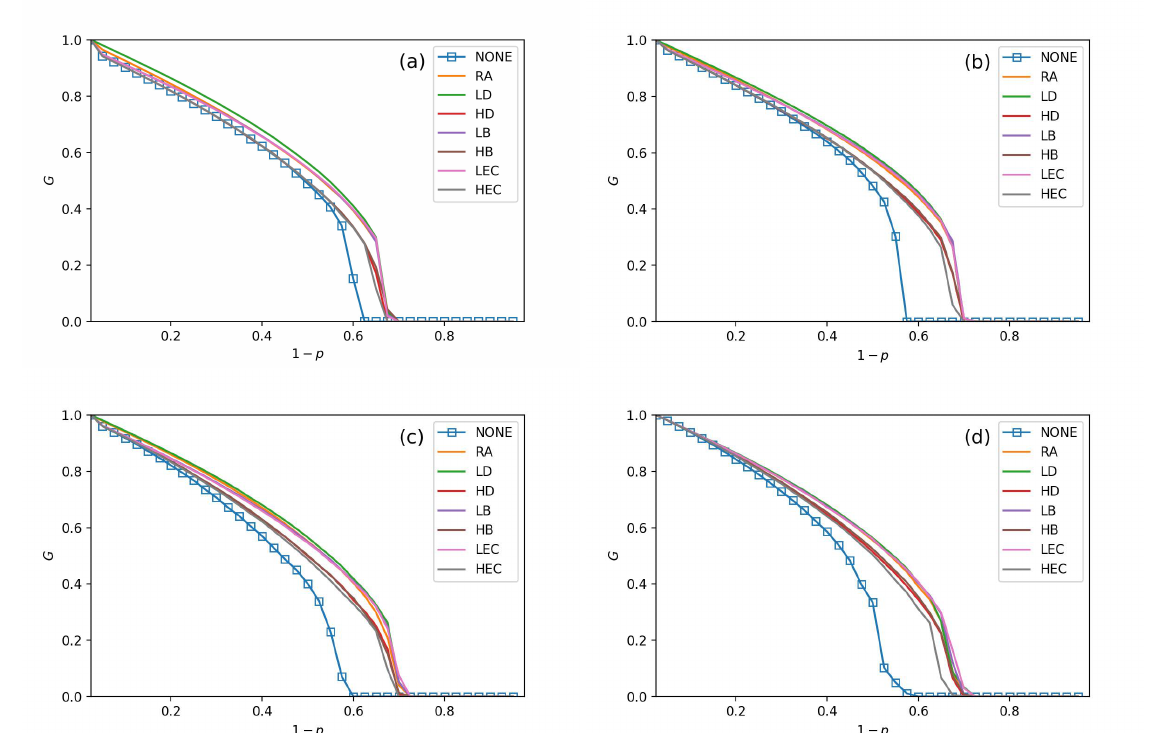
Figure 3. The fraction of function nodes when f L = 15% in ER-ER, ER-SF, SF-ER, and SF-SF system, which is shown in ( a – d ).